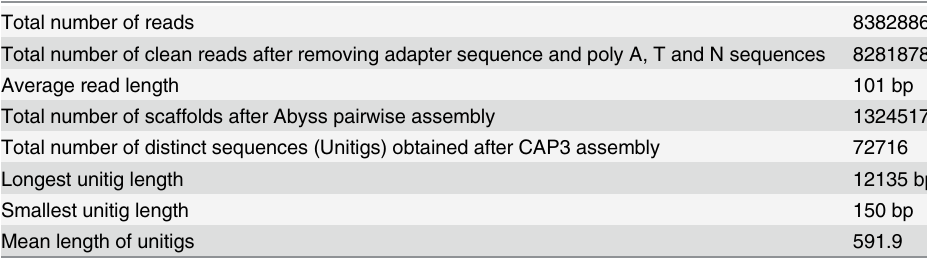
Table 1. Summary of the transcriptome sequencing and